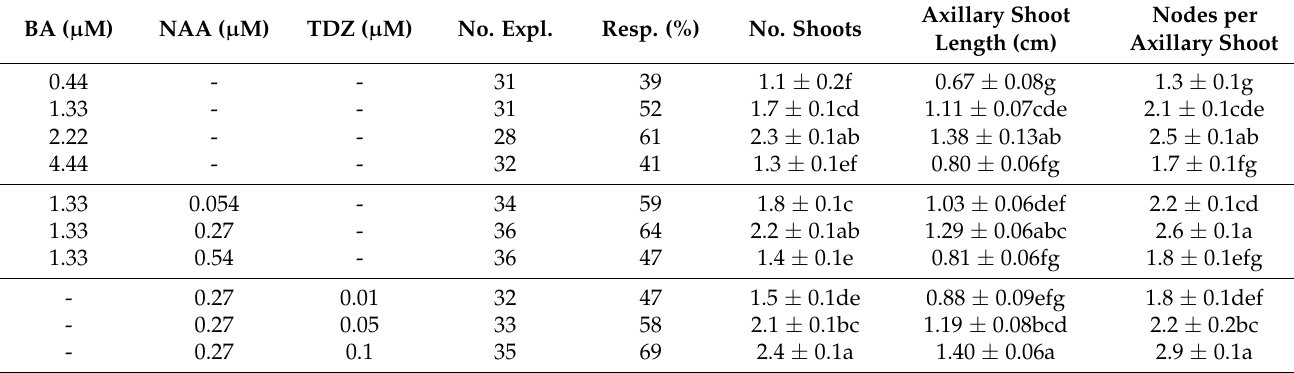
Table 1. Effects of hormone combinations on multiplication of decapitated shoots from greenhouse plants after 2